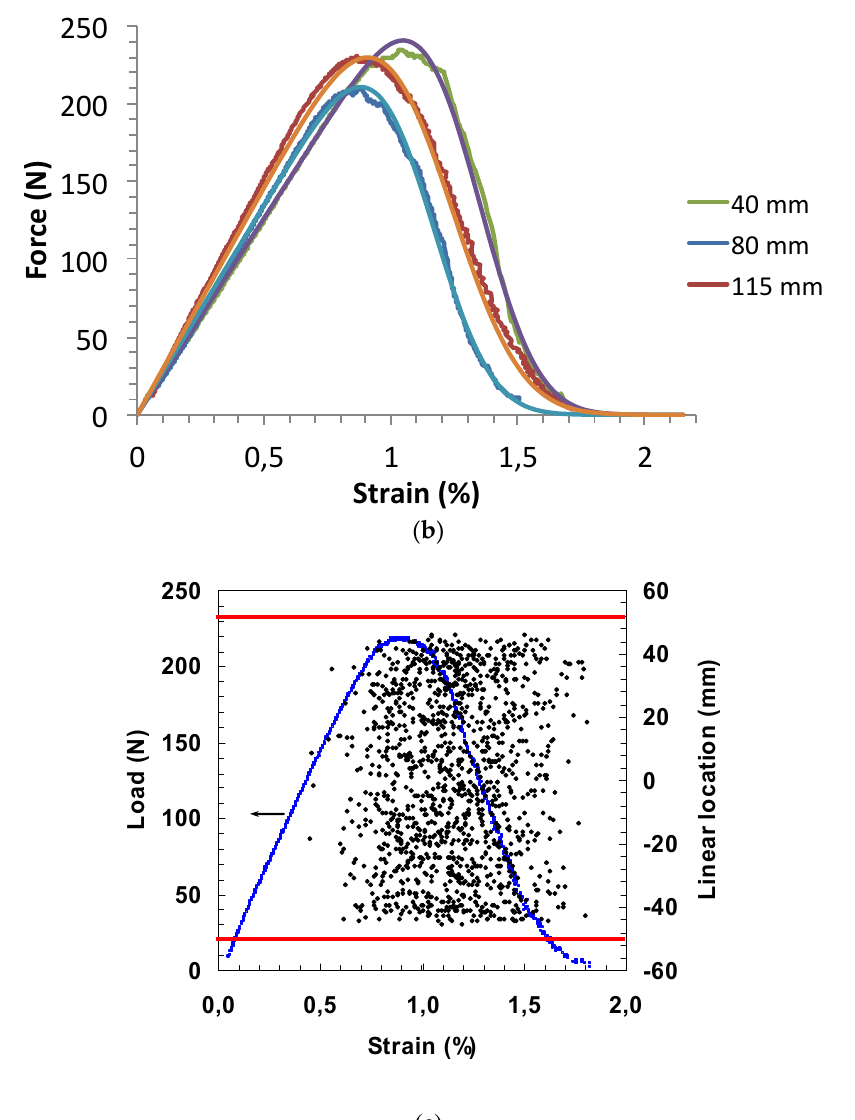
Figure 2. Force–strain curves obtained on tows with different gauge lengths and 1000 filaments: ( a ) 115 mm gauge length (the typical behavior of a tow with 500 filaments is also shown); ( b ) 40, 80 and 115 mm (also shown are the theoretical curves calculated using Equation (8) for the normal distribution of flaw strengths); ( c ) 115 mm and location of AE events along specimen axis (the parallel red lines delineate gauge length).